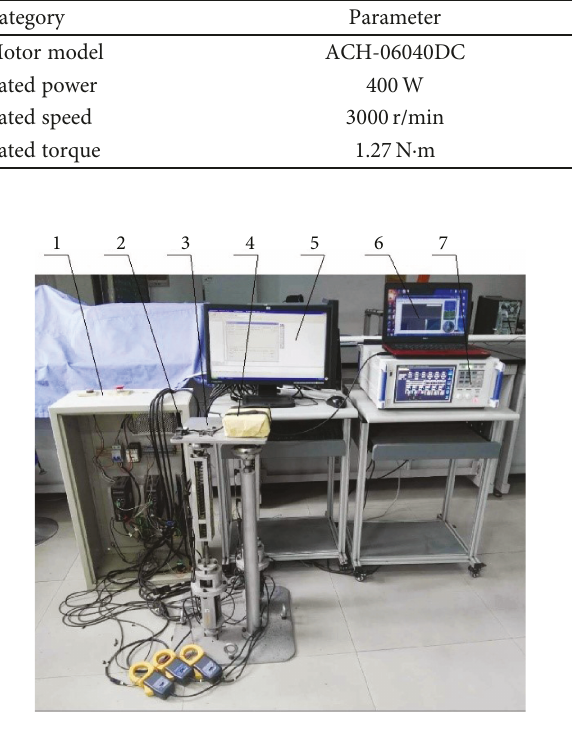
Figure 18: Experimental prototype of the robot and measurement system: (1) control cabinet, (2) gyro, (3) prototype of the robot, (4) load simulating patient foot, (5) PC for the control system of the robot, (6) PC for the measurement system, and (7) power analyzer.